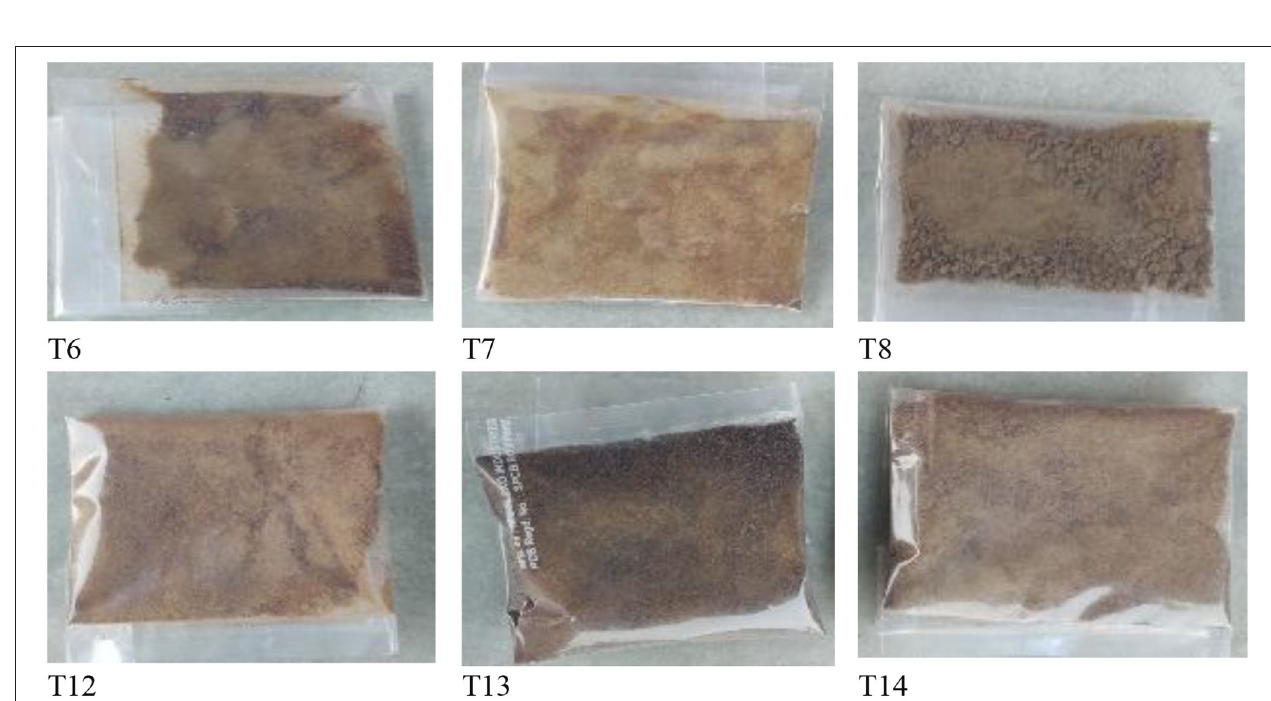
FIGURE 4 | Various forms of pretreated cabinet dried